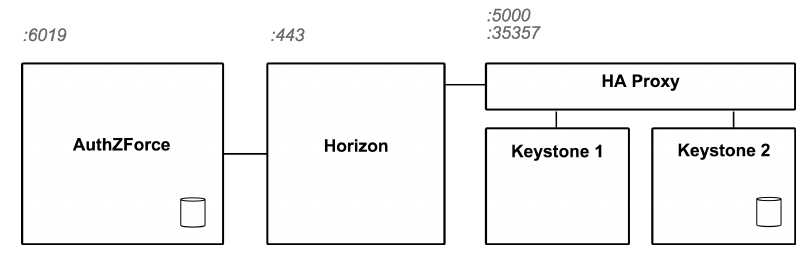
Figure 4. Deployment configuration. Table 1. Deployment servers characteristics.